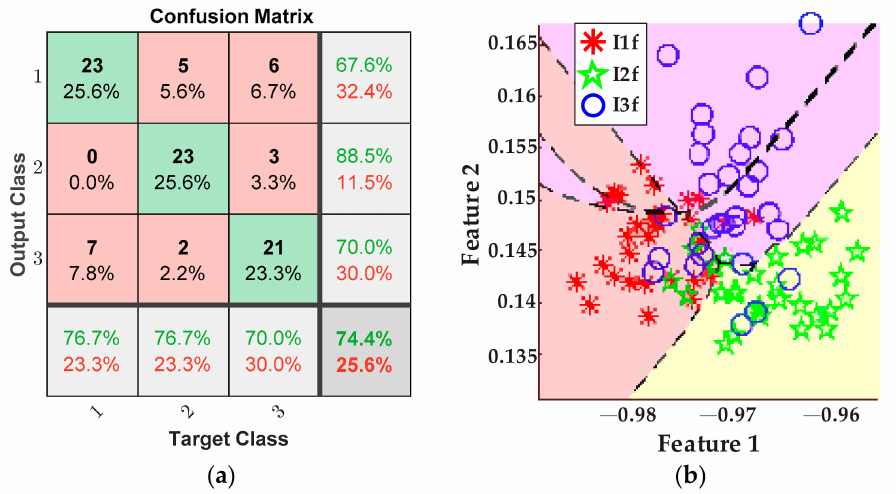
Figure 17. Results from feed rate variations for the stray flux sensors; ( a ) confusion matrix and ( b ) ANN